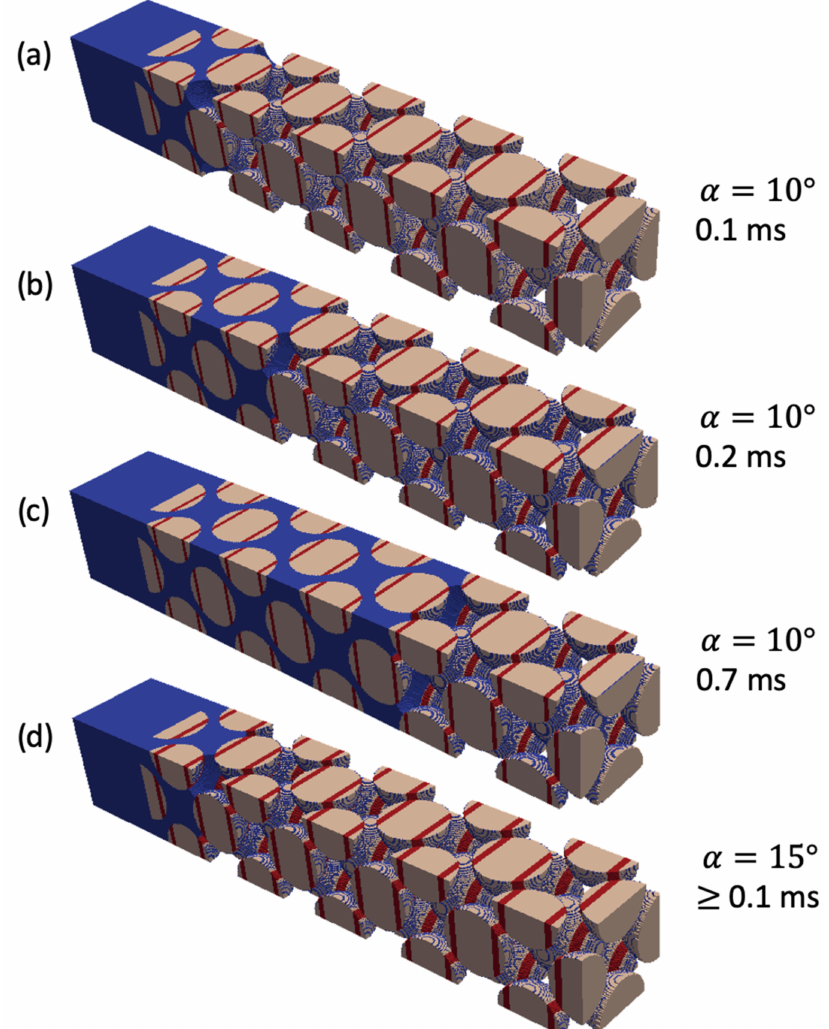
Figure 20. Infiltration in three-dimensional water conductive system with surface stripe width of α = 10 ◦ at ( a ) 0.1 ms, ( b ) 0.2 ms and ( c ) 0.7 ms as well as ( d ) equilibrium state of the water repellent system with α = 15 ◦ reached at 0.1